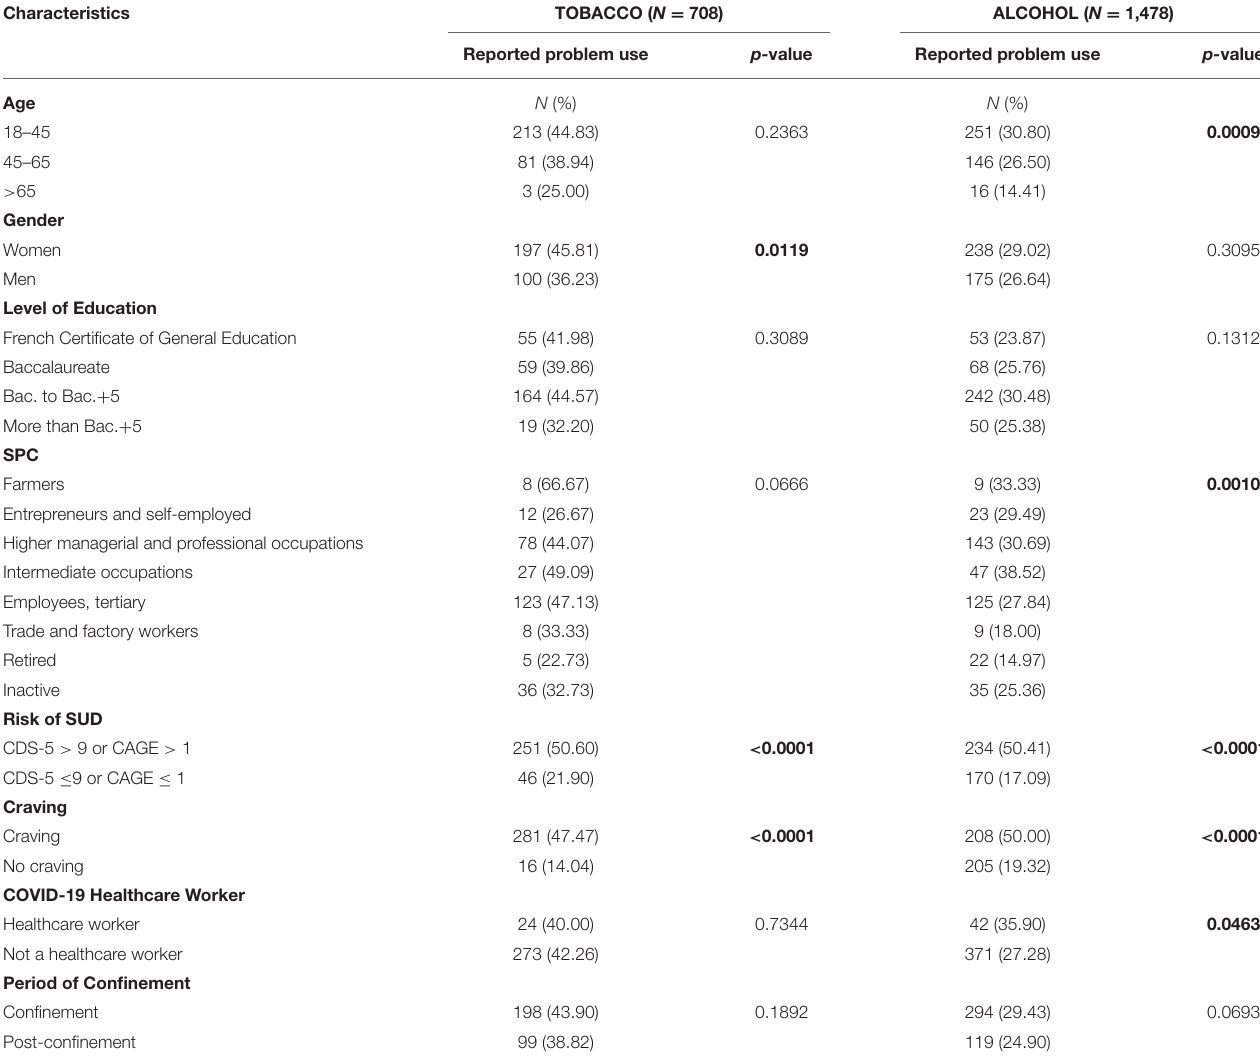
TABLE 2 | Factors associated with reported tobacco and alcohol problem use in the context of the COVID-19 pandemic (univariate analyses).